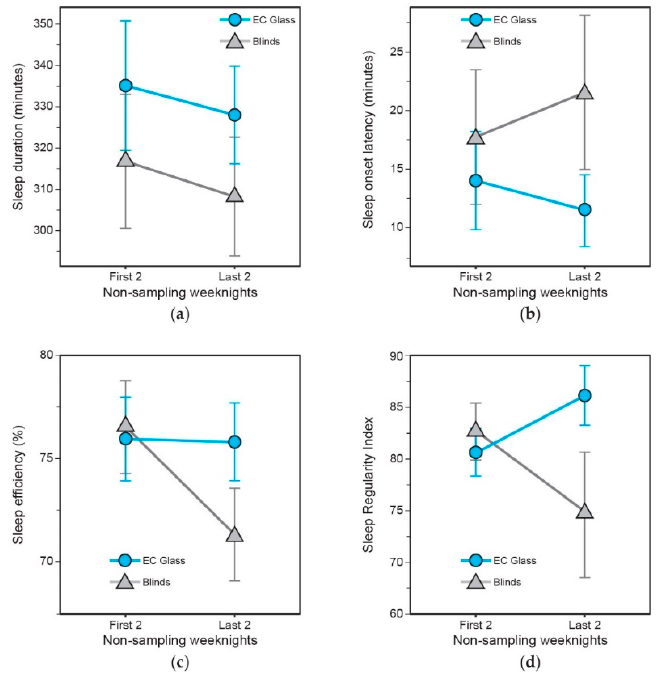
Figure 4. Objective sleep quality results between the two lighting conditions on the first two and last two non-sampling weeknights during the intervention periods: ( a ) sleep duration, ( b ) sleep onset la- tency, ( c ) sleep efficiency; and ( d ) sleep regularity (as calculated using the Sleep Regularity Index). Table 4. Results of the linear mixed effects models for actigraph-measured sleep quality metrics between the two experi- mental conditions, controlling for lifestyle factors.